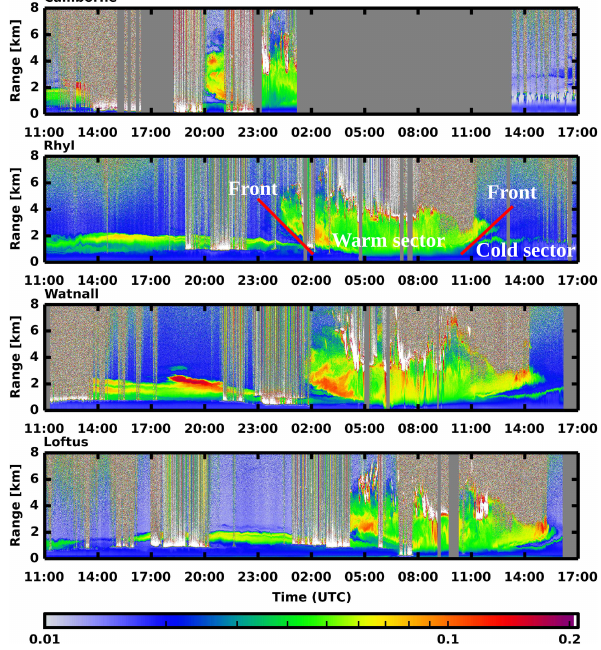
Figure 8. Lidar volume linear depolarisation ratios for 15 and 16 October 2017. Grey areas indicate no data, and white areas indi- cate large depolarisation values. An indication of the positions of the cold and warm fronts and sectors is shown in the second panel